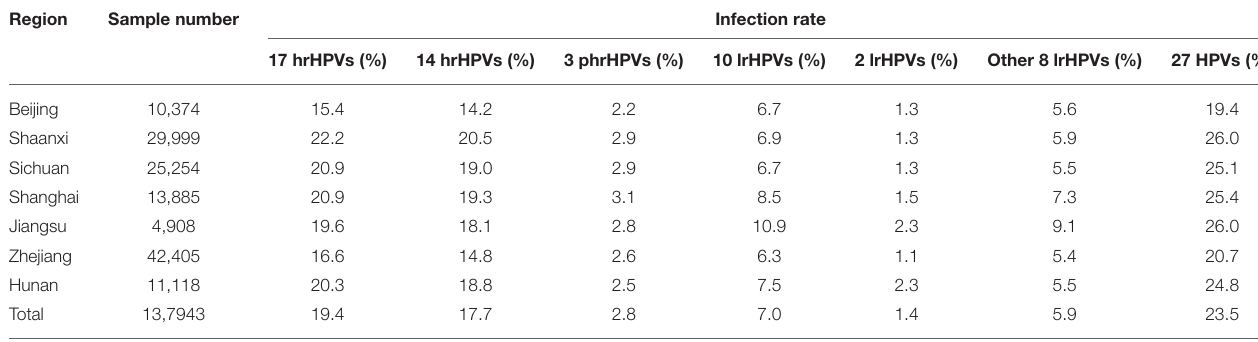
TABLE 2 | Overall and region-specific prevalence of 27 HPV genotypes. Region